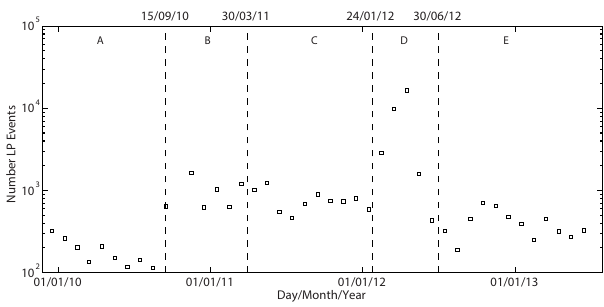
Figure 14. Number of long period seismic events per month. Data are taken from the SGC reports from